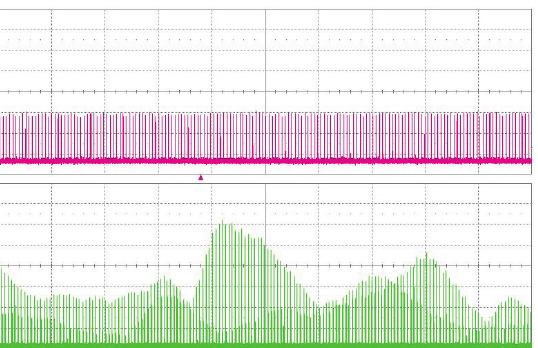
Figure 7. Oscillograms of dual-pulse regime, competition between both trains, 1.06 µ m pump (upper trace), PPLN OPO radiation at 1.53 µ m (lower trace). Time scale is 200